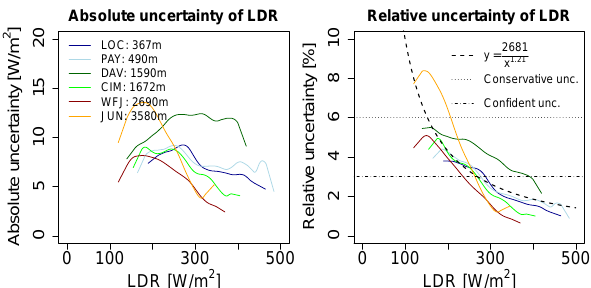
Fig. 11. Absolute and relative uncertainty of the modeled LDR. The clear-sky emissivity is estimated according to Konzelmann et al. (1994), and the all-sky parameterization is found in Eq. 23. The dashed black line denotes the fit of the function f ( LDR ) = σ LDR, rel , where x := LDR and y := σ LDR, rel